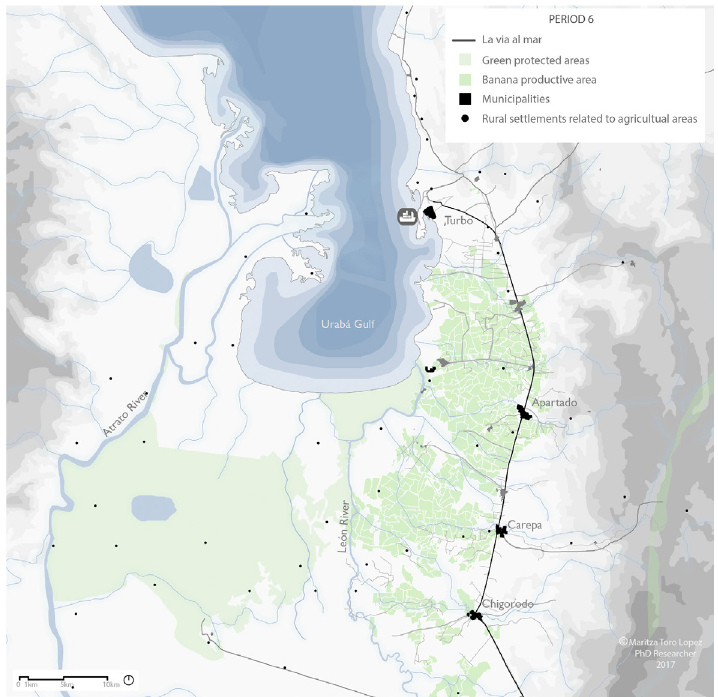
Fig. 7 . Period 6: The